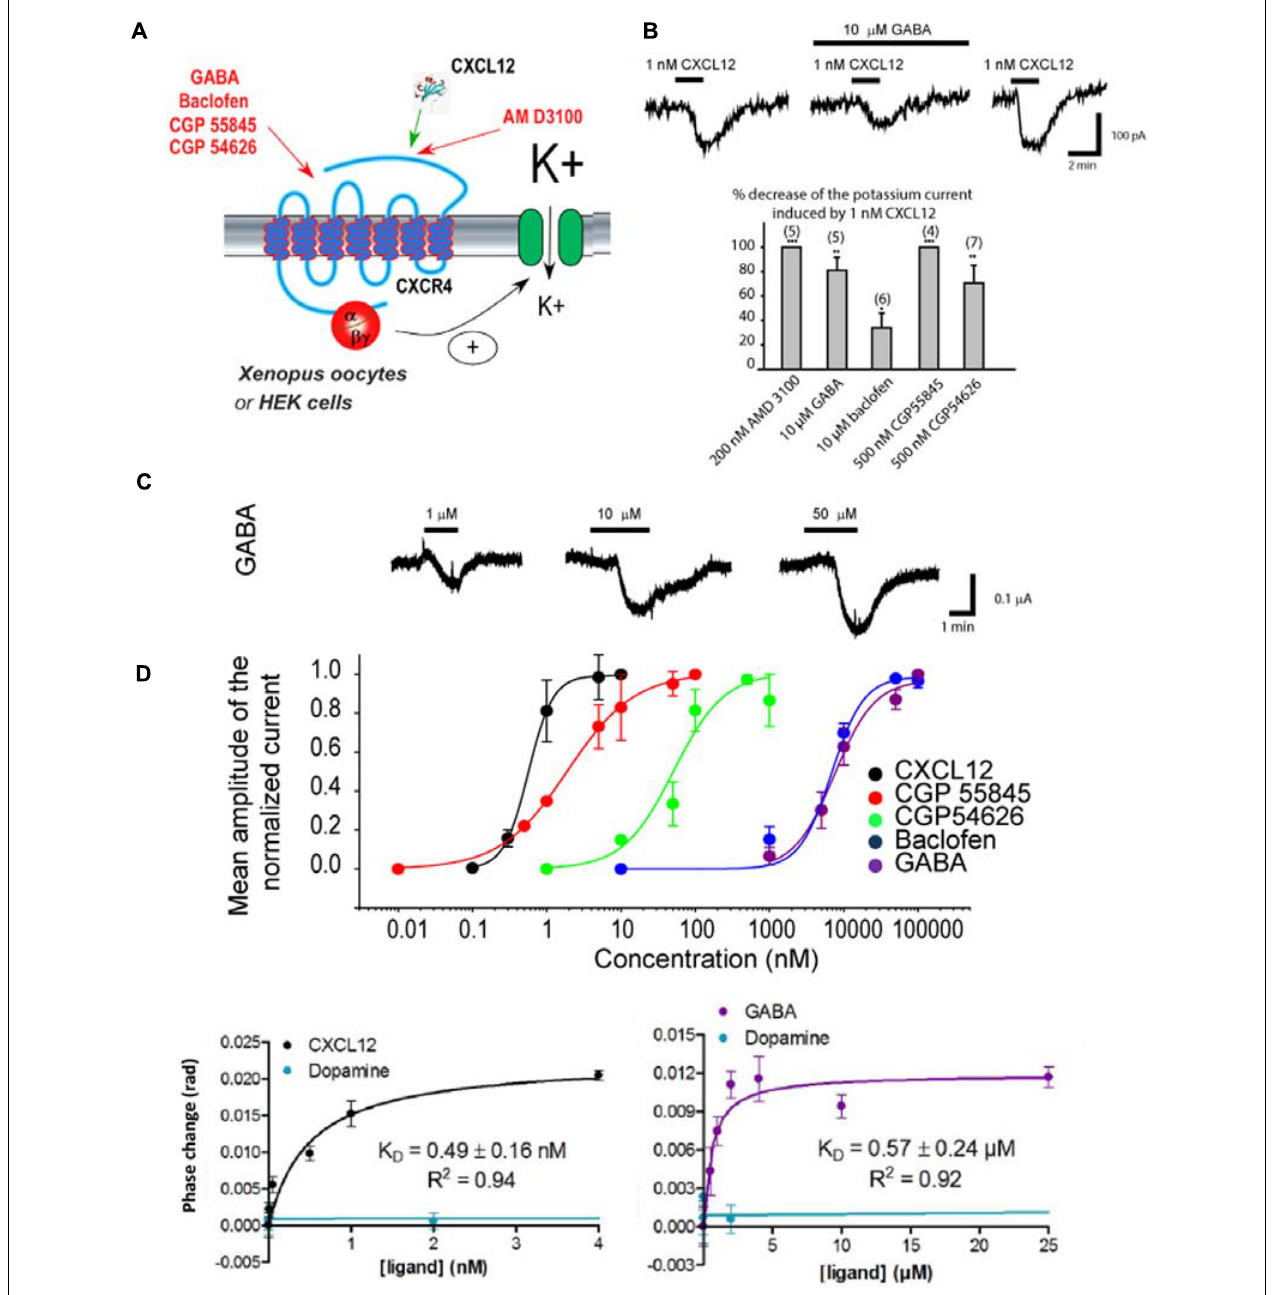
FIGURE 3 | GABA and agonists/antagonists of the GABA B receptor are allosteric modulators of CXCR4. (A) Scheme showing the diverse agents acting on the CXCR4 receptor that have been tested. CXCR4 has been co-expressed together with GIRK channels in Xenopus oocytes and human embryonic kidney (HEK293) cells.The activation of CXCR4 by the diverse agent tested was evaluated by measuring the amplitude of the GIRK current activated. (B) Results obtained in HEK293 cells expressing CXCR4 and reporting GIRK channel. Top :Traces recorded in response to the application of 1 nM CXCL12 with or without GABA. GABA inhibits partially the CXCL12 effect and this effect is reversible upon washout of GABA. Bottom : Histogram showing the allosteric actions of the CXCR4 antagonist AMD3100 compared to GABA and other agonists/antagonists of GABA B receptors. (C) Results